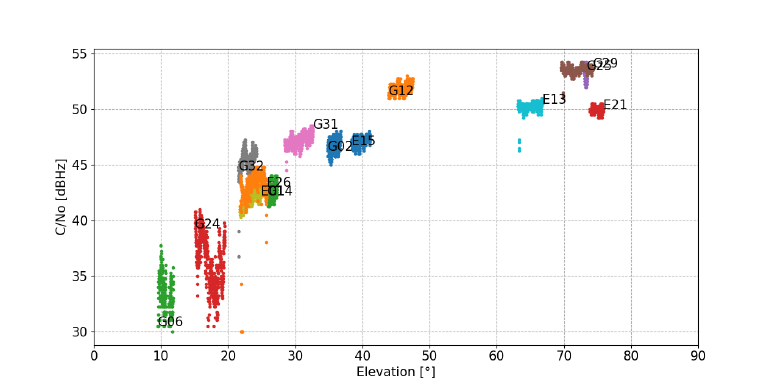
Figure 4. Carrier-to-noise density ratio (C/No) collected from the STONEX S900A as a function of the elevation angle for the satellite in view.